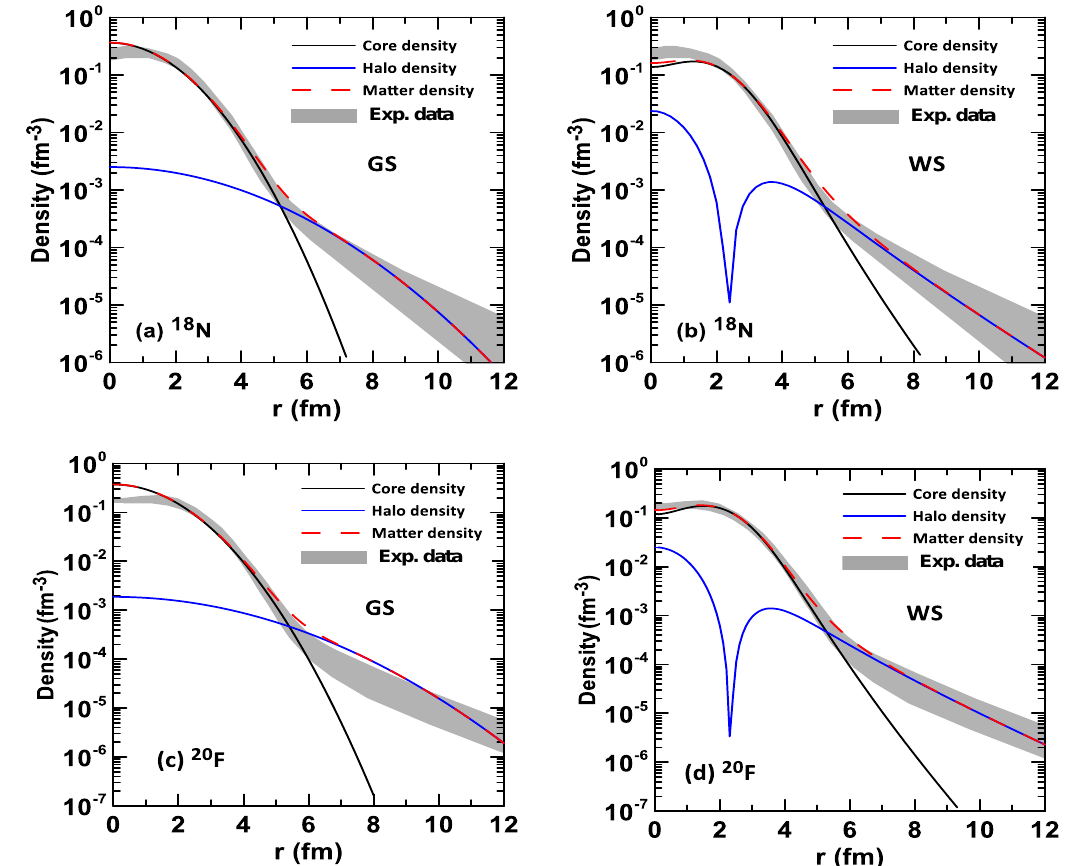
Figure 1: The , and distributions for 18 N and 20 F halo